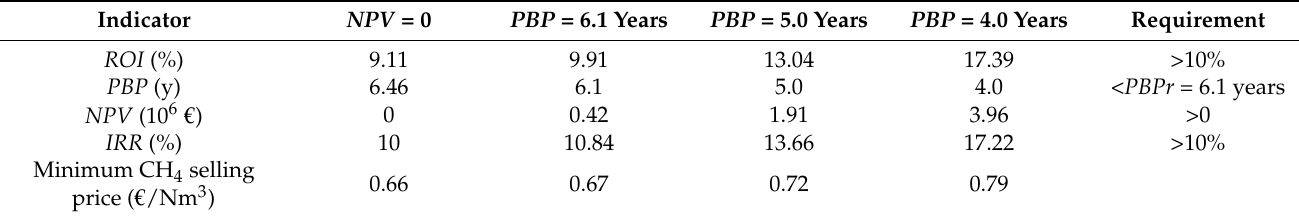
Table 5. Economic metrics and minimum CH 4 price for different profitability levels—base